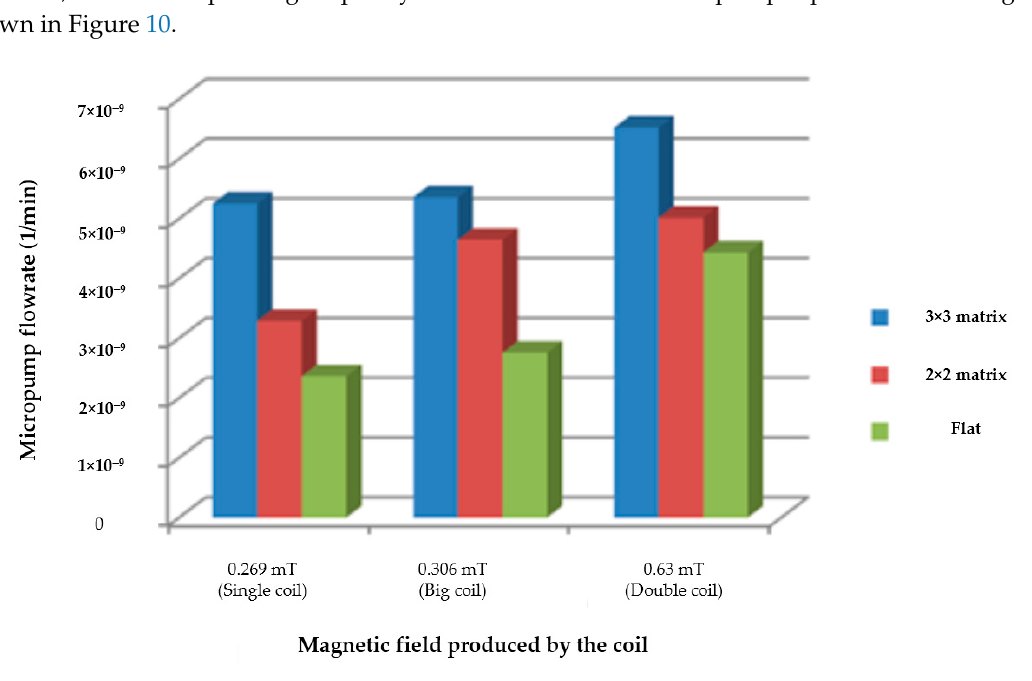
Figure 10. Fluid flow rate versus coil types.